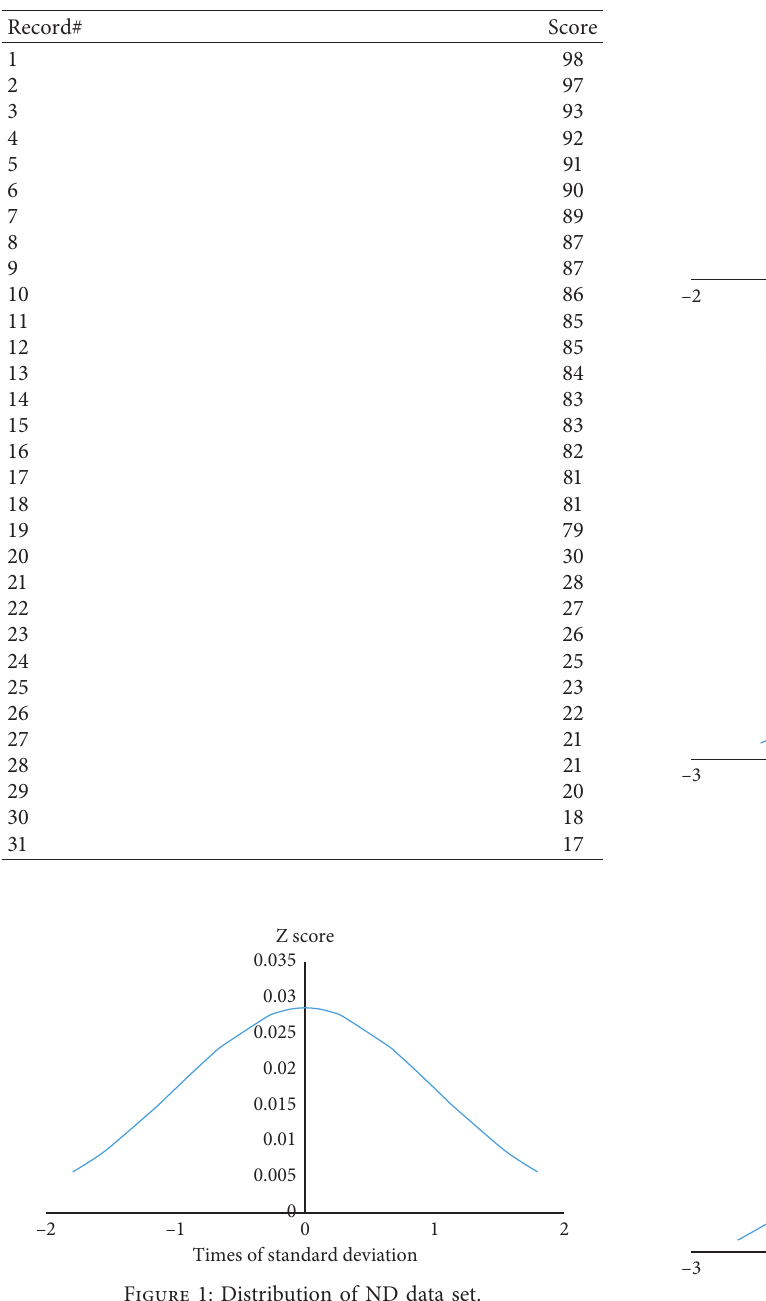
Figure 4: Distribution of RD −